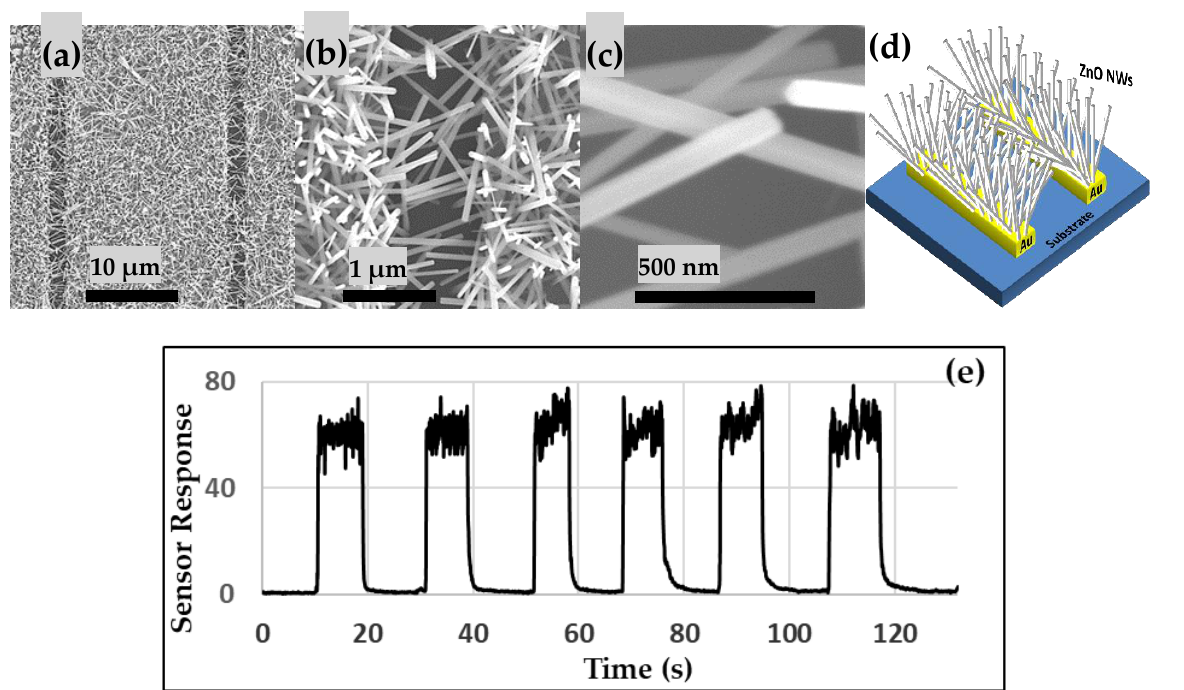
Figure 5. ( a – c ) SEM images at different magnifications, ( d ) a schematic diagram, and ( e ) response characteristics of the ZnO BNWs sensor.